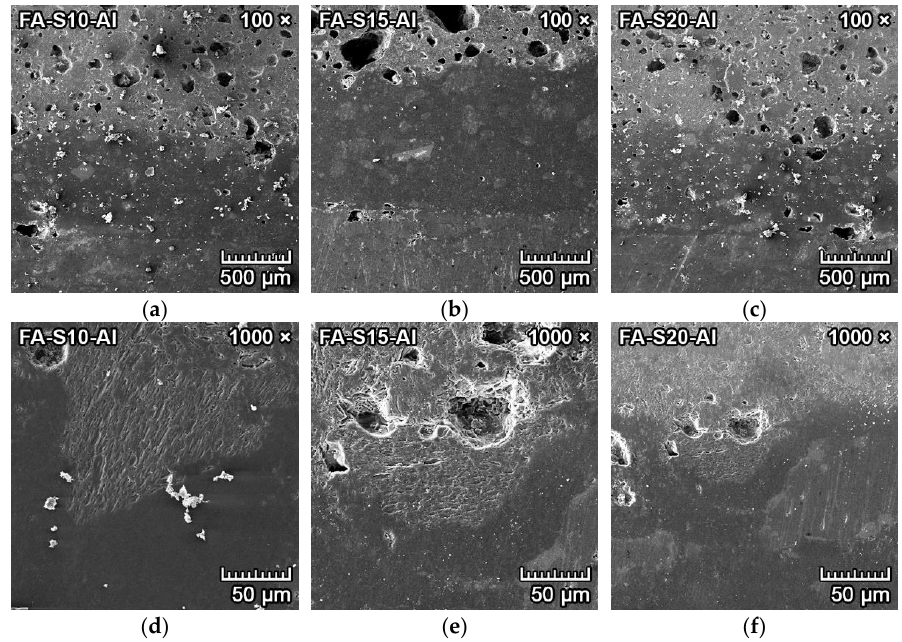
Materials 2022 , 14 , x FOR PEER REVIEW Figure 10. SEM microstructure of the transition zone between aluminum (dark grey and smooth) and forsterite – spinel ceramics (lighter and porous) of fly ash – based mixtures FA-S10, FA-S15 and FA-S20, with a magnification of 100× ( a – c ) and a magnification of 1000× ( d – f ). Figure 10a – f illustrates the corrosion resistance to aluminum of fly ash – based mix- tures FA-S10, FA-S15 and FA-S20. The corrosion resistance of fly ash – based mixtures to aluminum metal was very good, with the depth of penetration of aluminum around 1 mm for fly ash – based mixtures. The aluminum oxide layer (dark grey) was thinner in mixture FA-S20 due to the higher content of spinel, which also led to better corrosion resistance of this mixture.